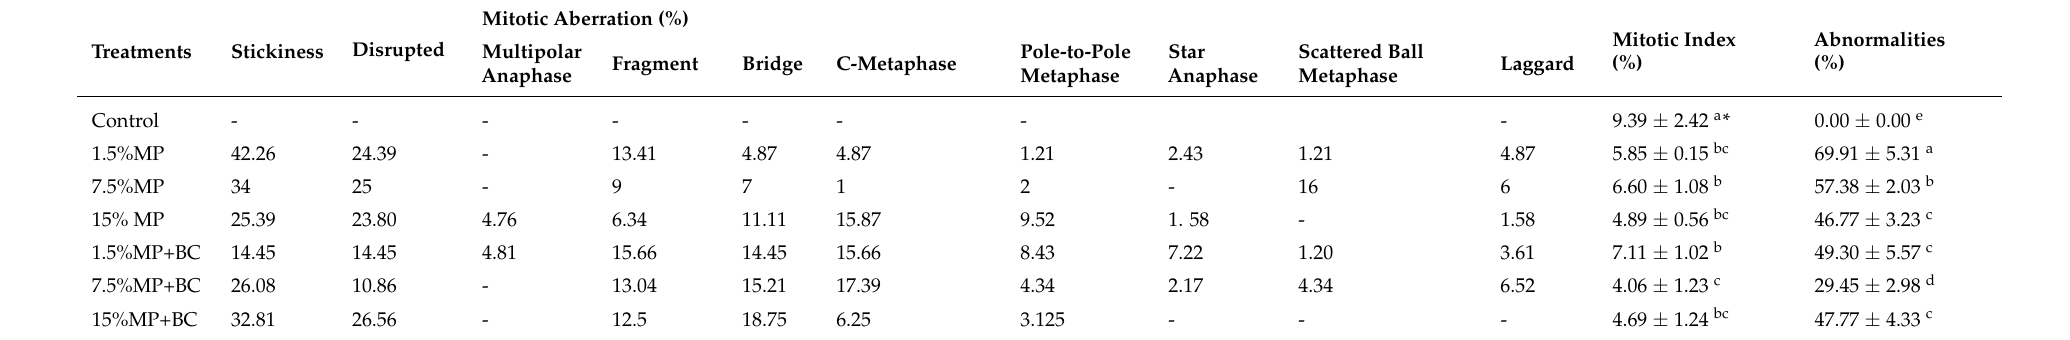
Table 7. Biochar effect on mitotic index, types and percentage of abnormalities of V. faba root tip cells under different level of